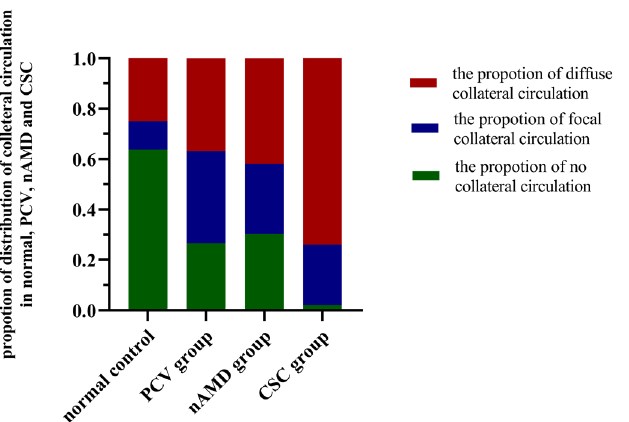
Figure 4. Comparisons of the proportion of the diffuse type (red column), focal type (blue column) and “no” type (green column) of collateral circulation among the four groups. There was a statistical difference in the proportion of diffuse collateral circulation between the PCV, nAMD, CSC, and normal control groups (χ 2 = 31.09, p < 0.001). PCV: polypoidal choroidal vasculopathy; nAMD: neovascular age-related macular degeneration; CSC: central serous chorioretinopathy; Pachy-PCV: PCV with pachychoroid.